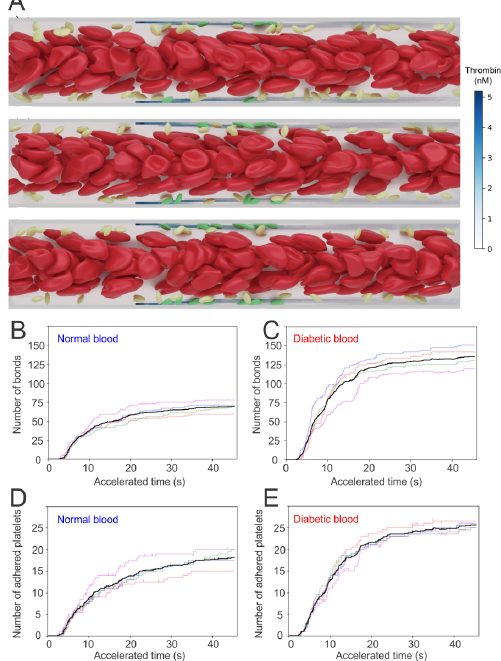
Figure 7. ( A ) Simulation results of normal RBCs and platelets moving in the microchannel. Activated platelets adhere to the injury sites after they become activated by thrombin with concentration >1 nM. The number of bonds generated between platelets and injury sites for ( B ) normal and ( C ) diabetic blood as well as the number of adhered platelets for ( D ) normal and ( E ) diabetic blood are recorded for 40 s. Figure is reproduced from